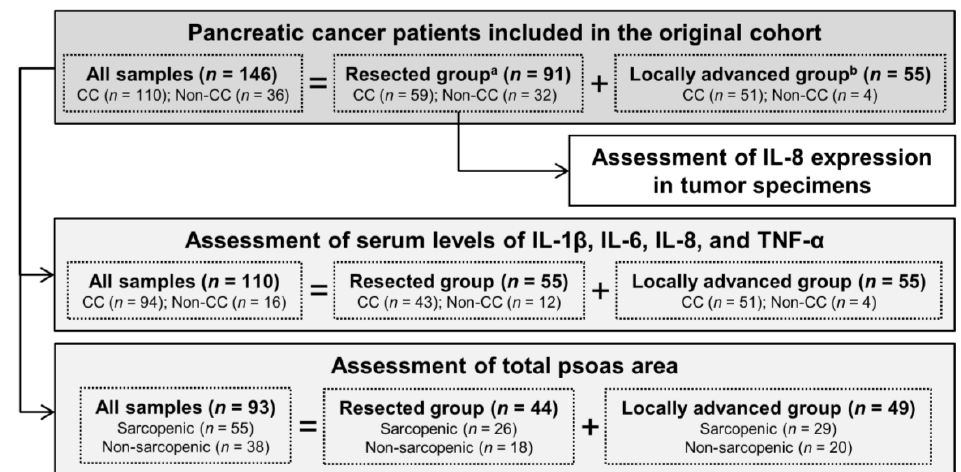
Figure 1. Assembly of study cohort. a, patients with surgical treatment. b, patients with unresected disease. Abbreviations: CC, positive cancer cachexia status; Non-CC, negative cancer cachexia status; IL, interleukin; TNF, tumor necrosis factor.